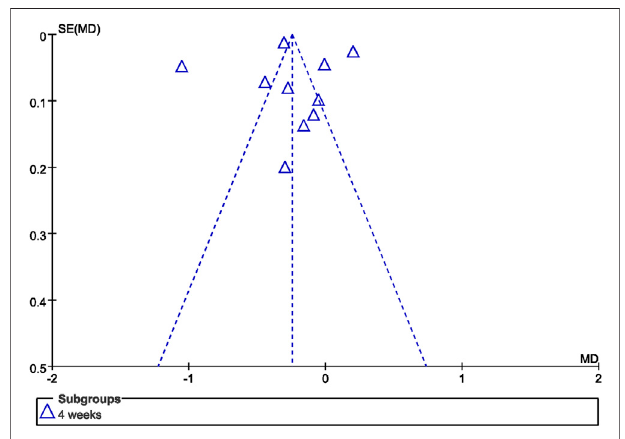
FIGURE 8 | Funnel plot of GI at 4